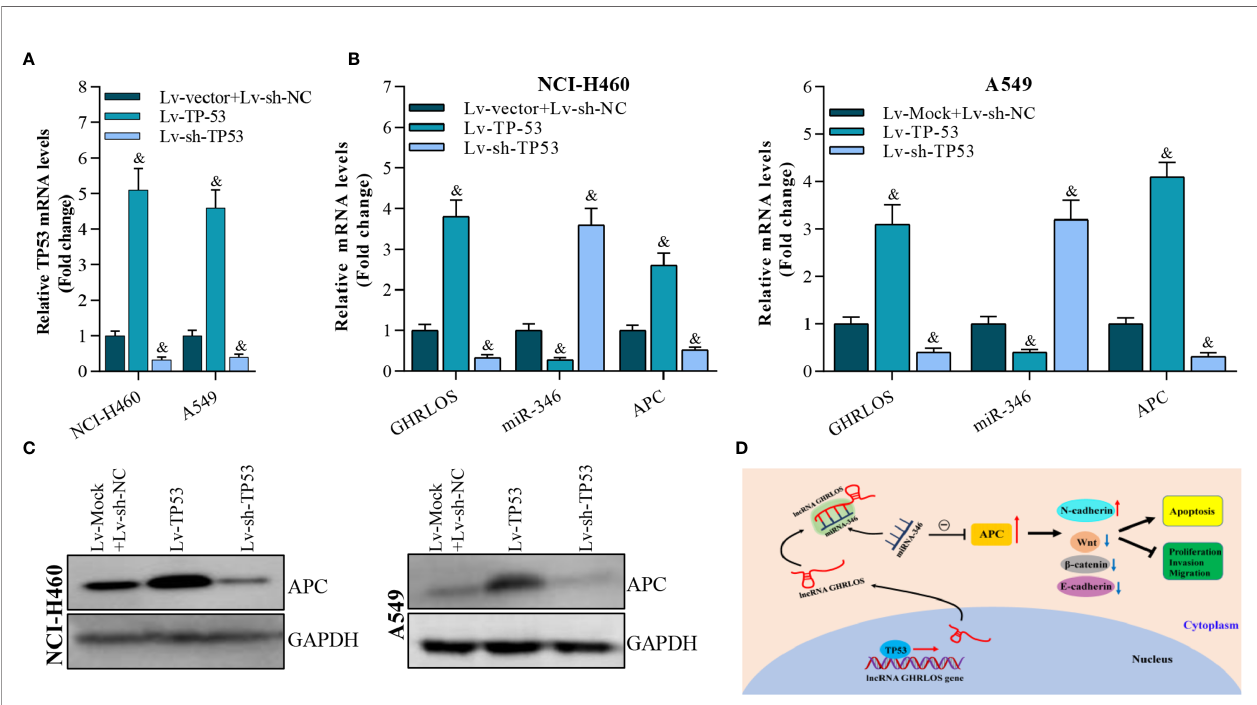
FIGURE 8 | APC expression is modulated by overexpression or interference with TP53 expression. (A) qRT-PCR analysis on TP53 expression after overexpressed- or knockdown-TP53 for 48 h, &p< 0.01 vs. Lv-vector. (B) qRT-PCR analysis on APC, lncRNA GHRLOS, and miR-346 expression after indicated lentivirus infection for 48 hr in A549 and NCI-H460 cells, &p< 0.01 vs. Lv-vector. (C) Western blot analysis on APC expression in A549 and NCI-H460 cells with indicated infection. (D) Schematic presentation of molecular mechanism of lncRNA GHRLOS mediated cell proliferation, invasion and apoptosis in